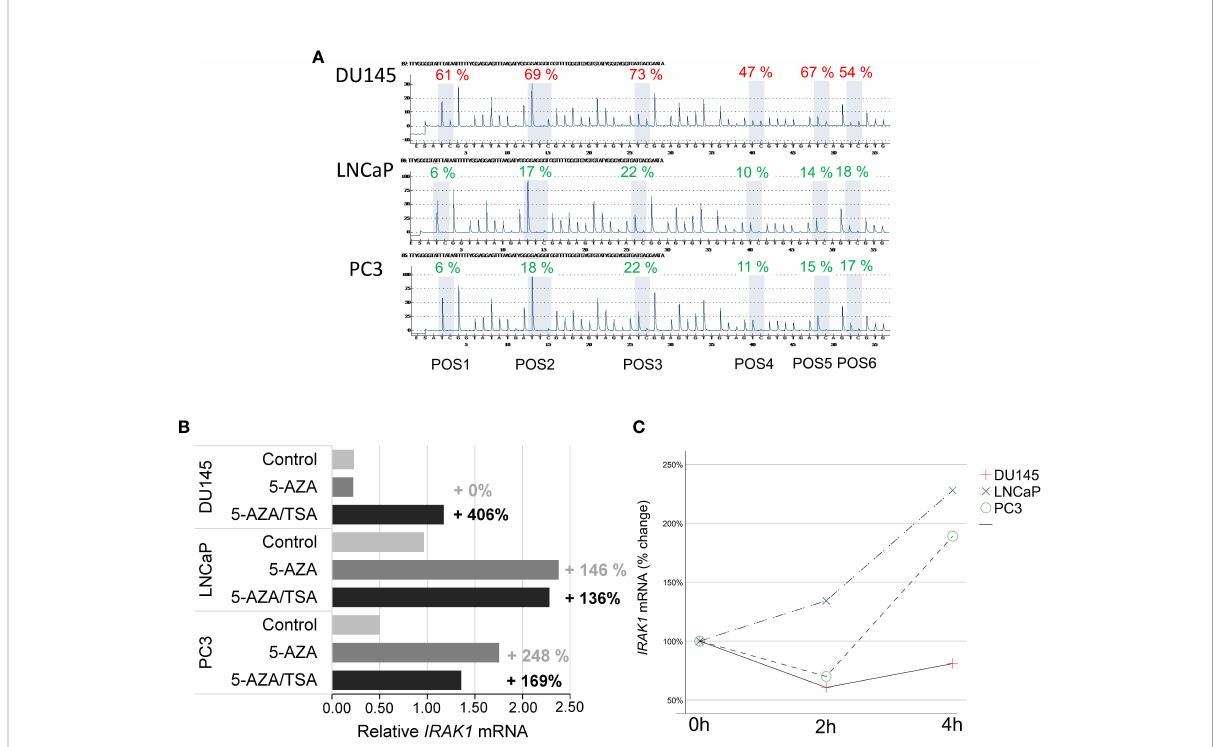
FIGURE 6 Analysis of DNA methylation in IRAK1 -DMR and its impact on IRAK1 expression using prostate cancer cell lines. (A) Pyrosequencing of IRAK1 - DMR showed strong methylation in DU145 (47-69%) and weak methylation in LNCaP and PC3 cells (8-22%). (B) Effect of the DNA demethylating agent 5-Aza-2-deoxycytidine (5-AZA) and the histone-deacetylase inhibitor Trichostatin A (TSA) on IRAK1 expression. In DU145, endogenous IRAK1- mRNA levels were low and increased over 400% after combined 5-AZA/TSA-treatment. LNCaP and PC3 cell lines showed higher endogenous IRAK1 expression and lesser response to 5-AZA/TSA treatment than DU145. (C) Treatment with the uropathogenic E . coli strain UTI89 for 4 hours activated IRAK1 expression in LNCaP and PC3, and had no effect in DU145 cells. Expression of IRAK1 in untreated cells is set as